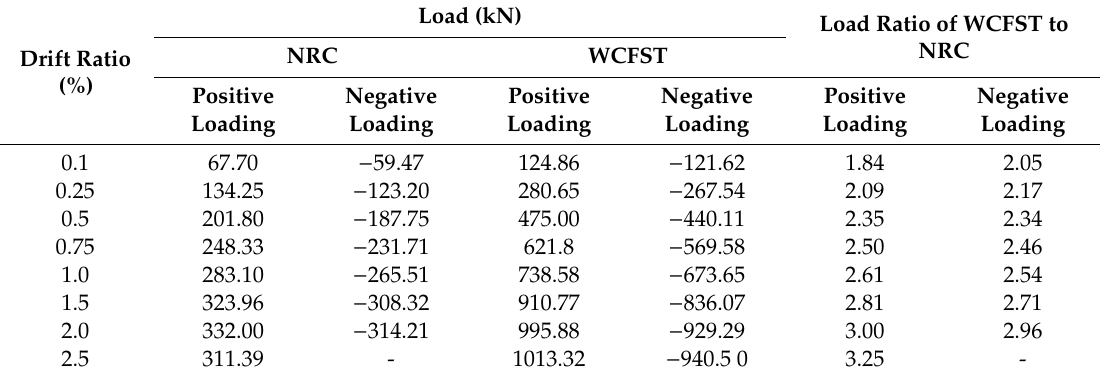
Table 3. Comparison of loads according to the drift